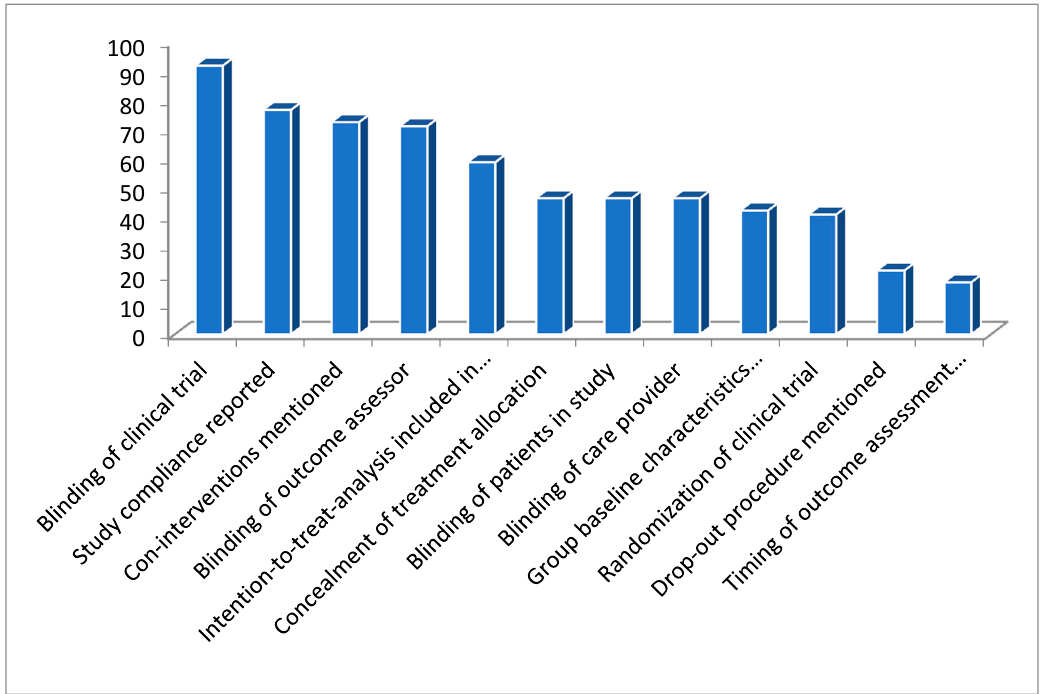
Figure 3. Figure representing the percentage of deficiencies in these clinical trials.